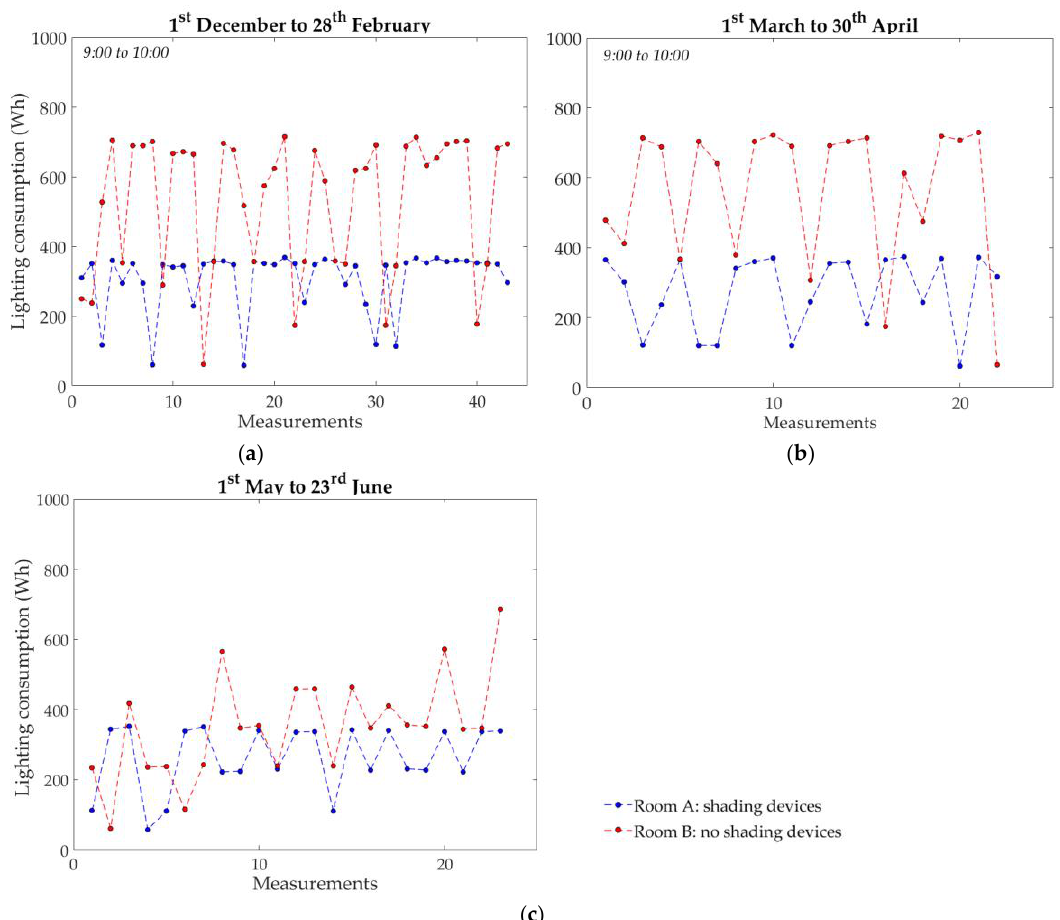
Figure 6. Analysis of the hours in which both classrooms simultaneously recorded lighting consumption, during the first hour of class (9:00 to 10:00): ( a ) winter; ( b ) mid-season; and ( c ) summer.